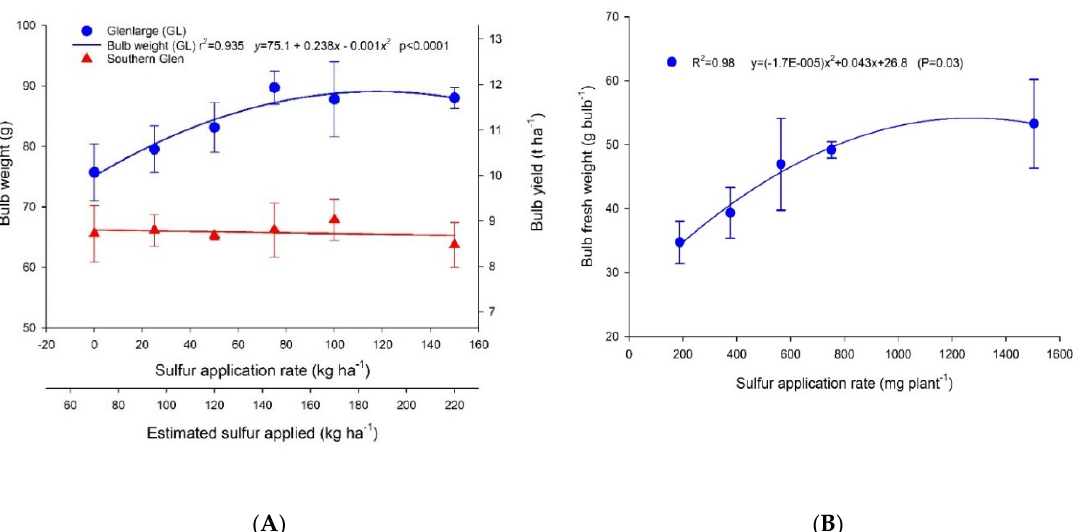
Figure 1. Bulb fresh weight and yield for cultivars Glenlarge (blue lines and symbols) and Southern Glen (red lines and symbols) grown in the field ( A ) and cultivar Glenlarge grown in solution culture ( B ). Values are means of 4 replicates with standard error bars shown if not obscured by the symbols. The lines represent the best-fit linear or quadratic equations.